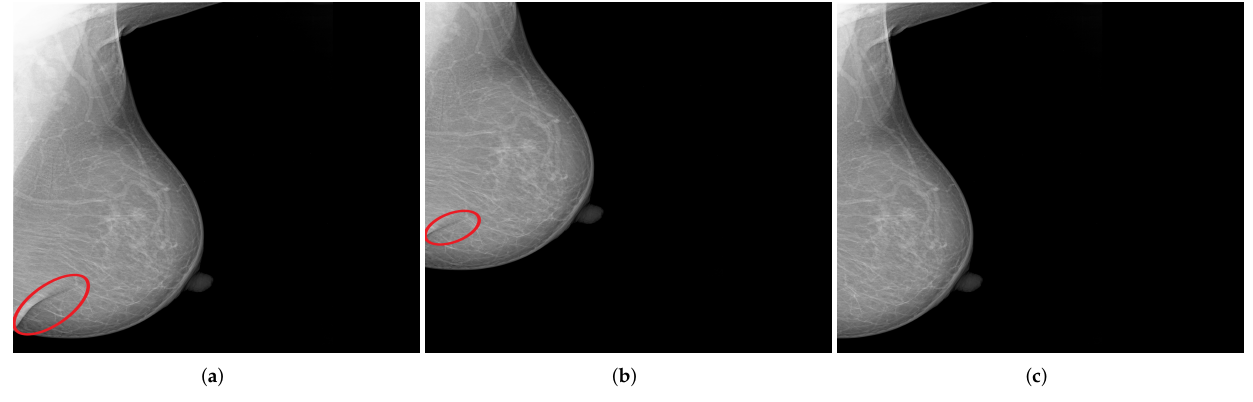
Figure 13. Examples of generated mammograms showing the significance of the selected shift value. ( a ) Original mammogram with a skin fold (cf. red circle); ( b ) created mammogram with a preserved skin fold (cf. red circle); ( c ) missing skin fold due to horizontal shift with an inappropriate value.